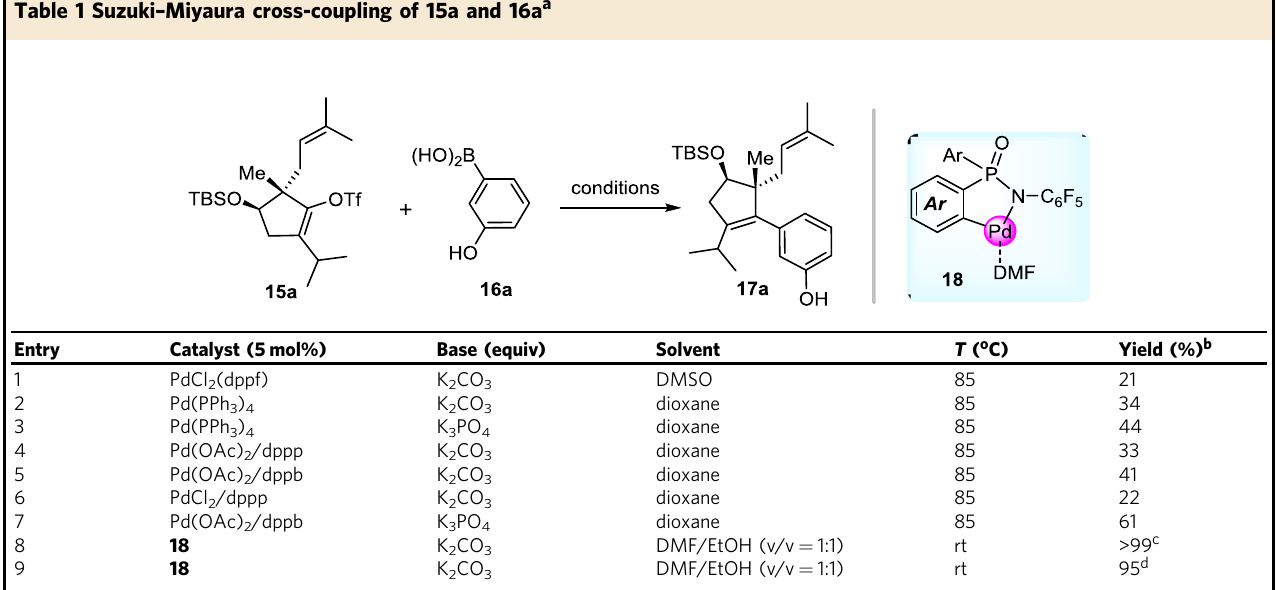
c The reaction was run at rt for 5h d The reaction was performed with 6.6g of 15a and was quenched until 15a had disappeared as monitored by